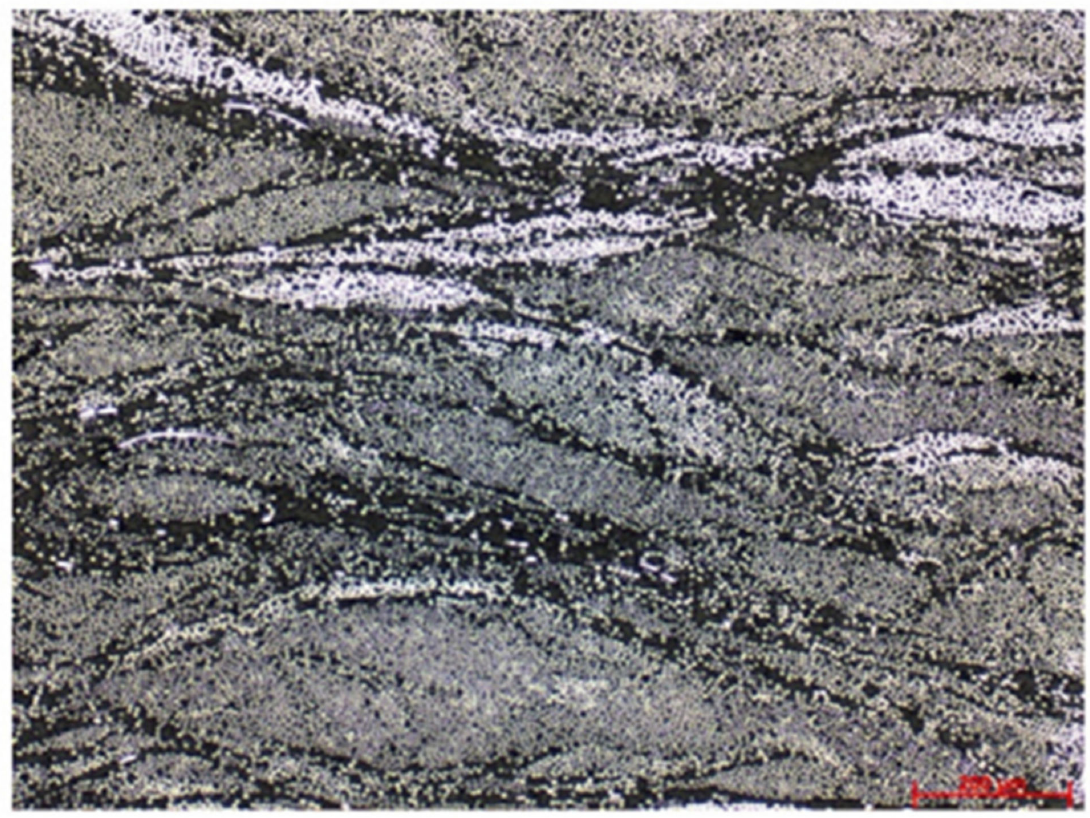
Figure 6. Optical micrograph of yarn-based composite produced via compression molding. Reprinted with permission from [84]. Copyright 2019